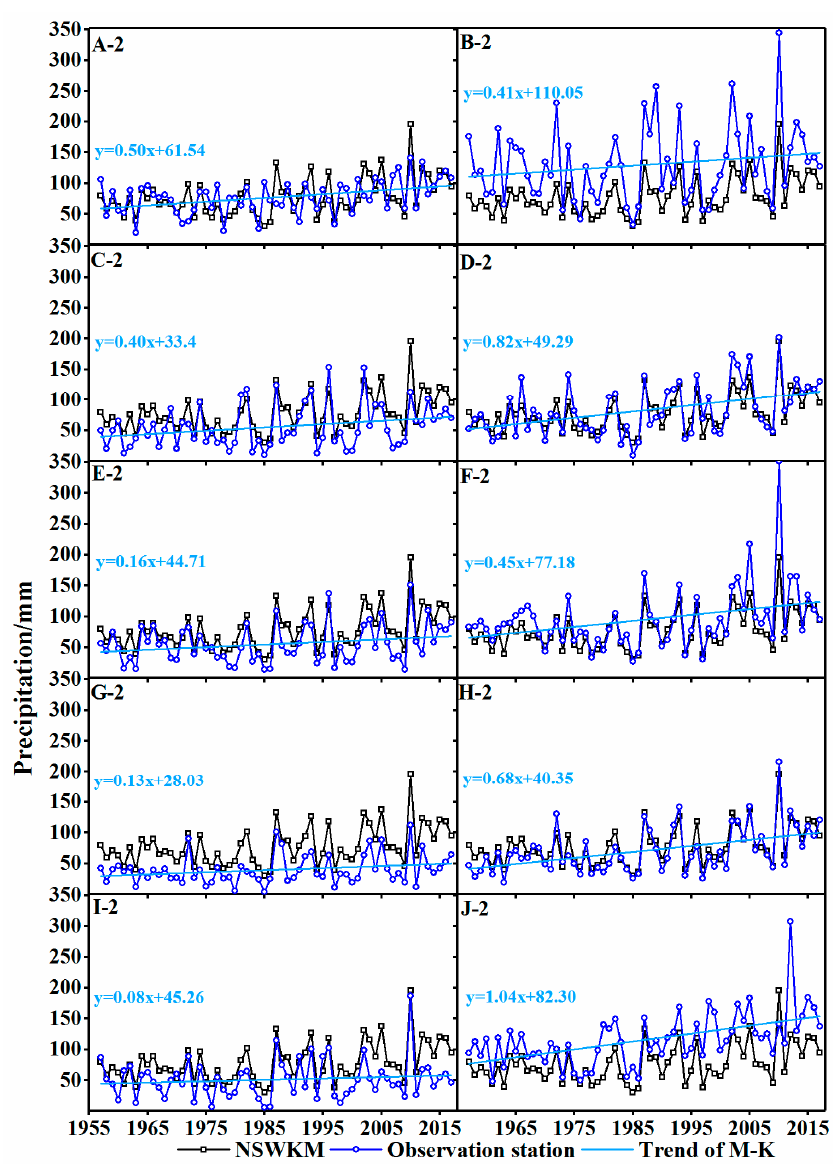
Figure 6. Annual mean precipitation of weather stations and hydrological stations on the NSWKM from 1957 to 2017. NSWKM data are average data of all meteorological and hydrological stations (A–J in Figure 1).